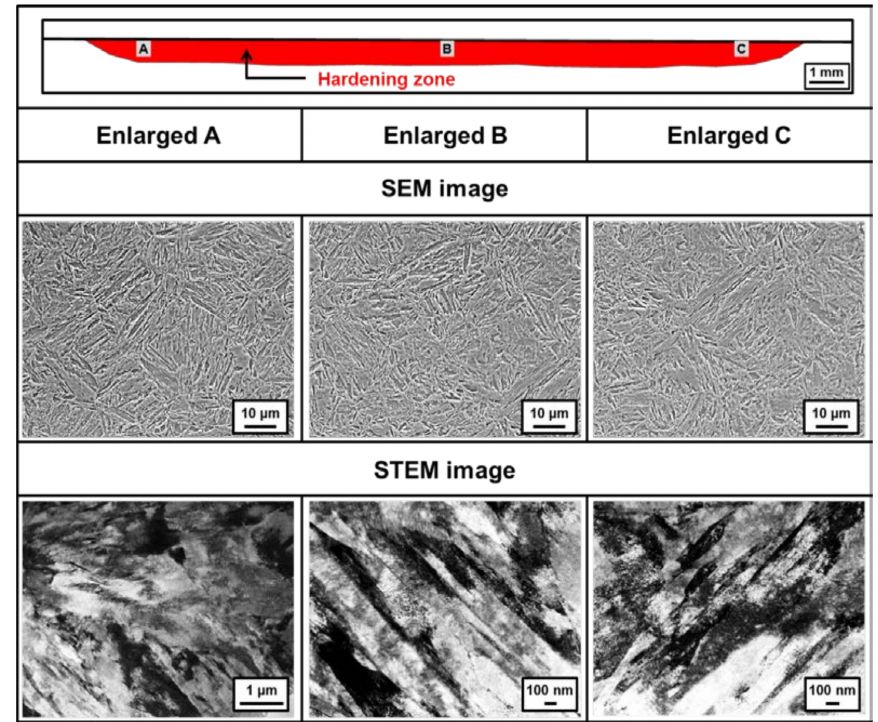
Figure 10. Typical SEM and STEM micrographs of the hardening zone of P20-improved steel after laser-assisted heat treatment at 1473 K.